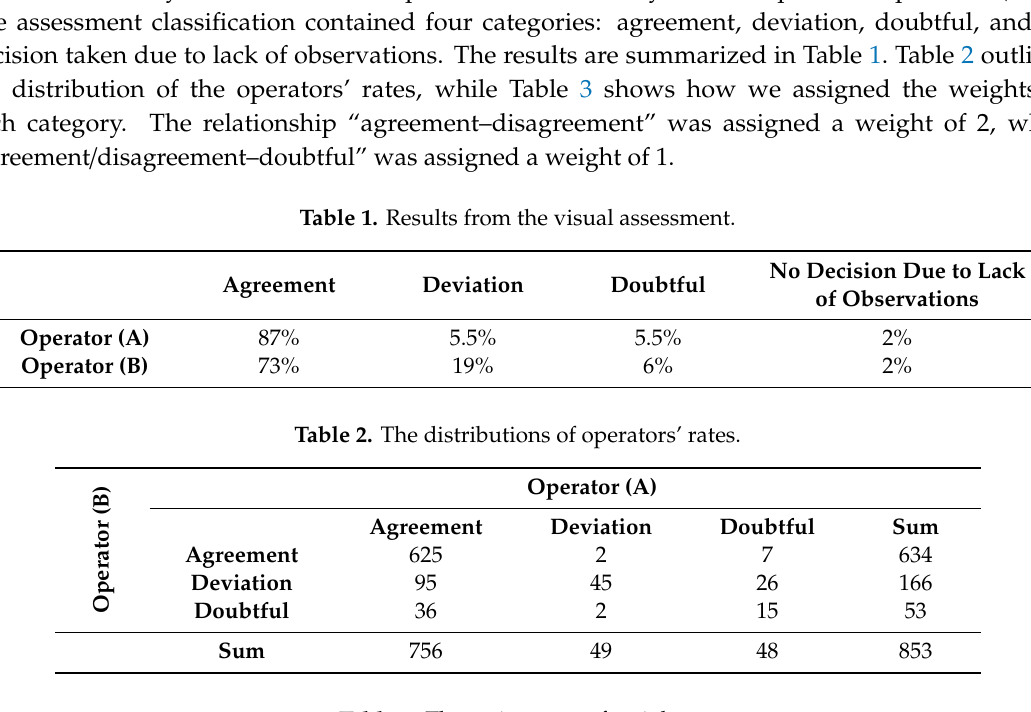
Table 3. The assignment of